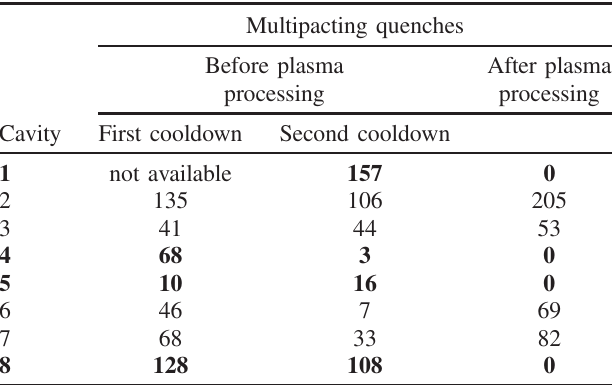
TABLE II. Number of MP quenches measured for each cavity in two different cooldowns prior to plasma processing and the one cooldown after plasma cleaning. The four cavities to which plasma processing was applied are highlighted in